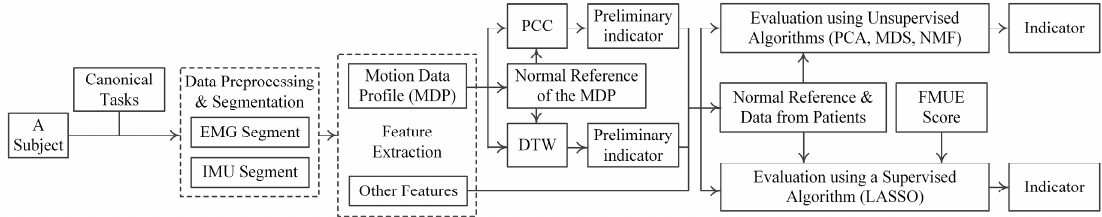
Figure 3. Flow chart of data analysis. PCA: principal component analysis; MDS: multidimensional scaling; NMF: non-negative matrix factorization; LASSO: least absolute shrinkage and selection operator.